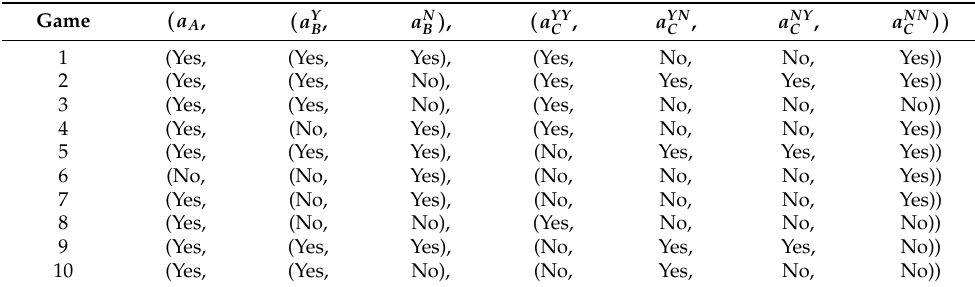
Table A1. Subgame-perfect Nash